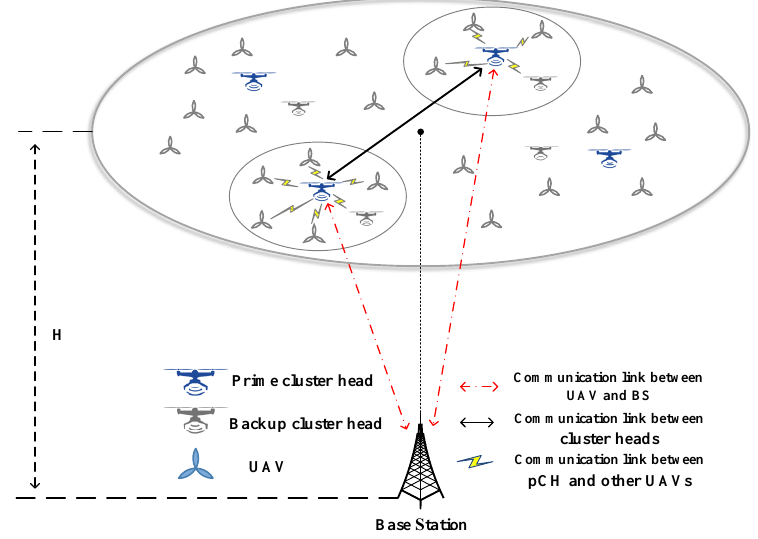
Figure 1. Cluster-based UAV communication